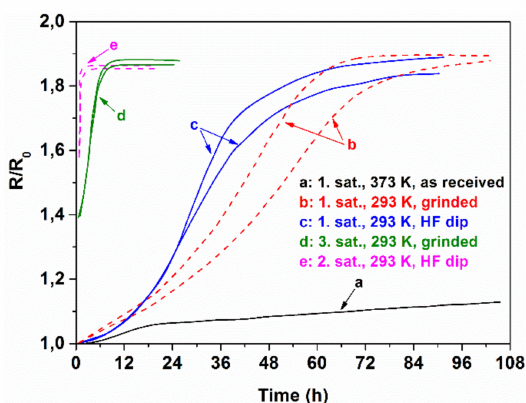
Figure 46. Time dependence of the relative resistance of Ni 67 Zr 33 samples during repeated absorption–desorption cycles. Adopted from [138], with permission from Elsevier,